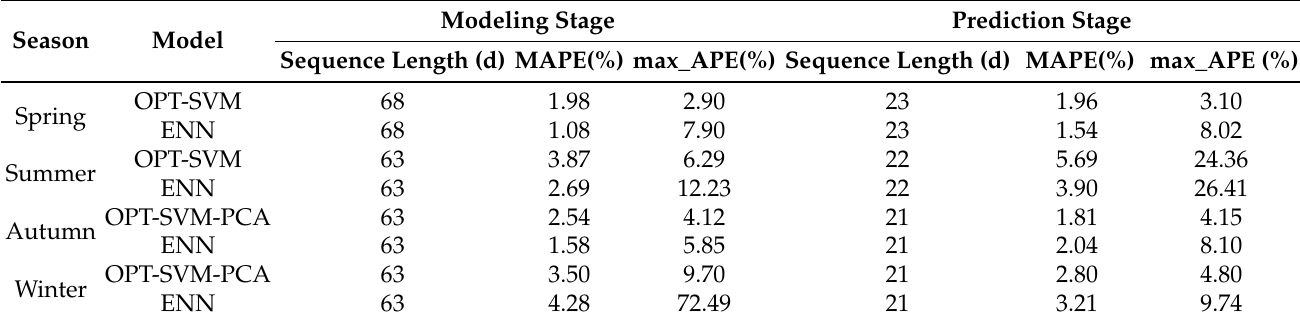
Table 2. Forecasting accuracy comparison of OPT-SVM and